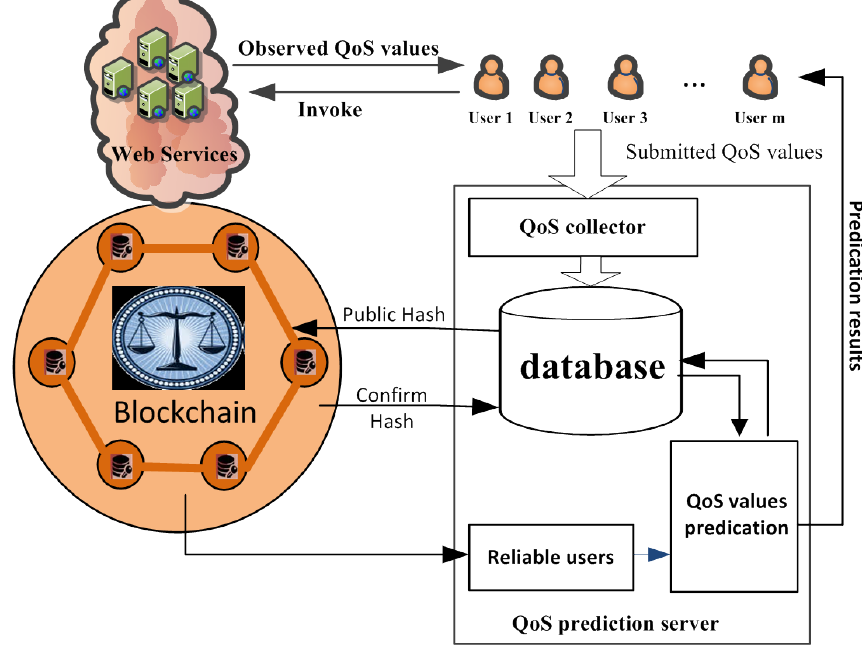
Figure 1. Blockchain-based QoS prediction